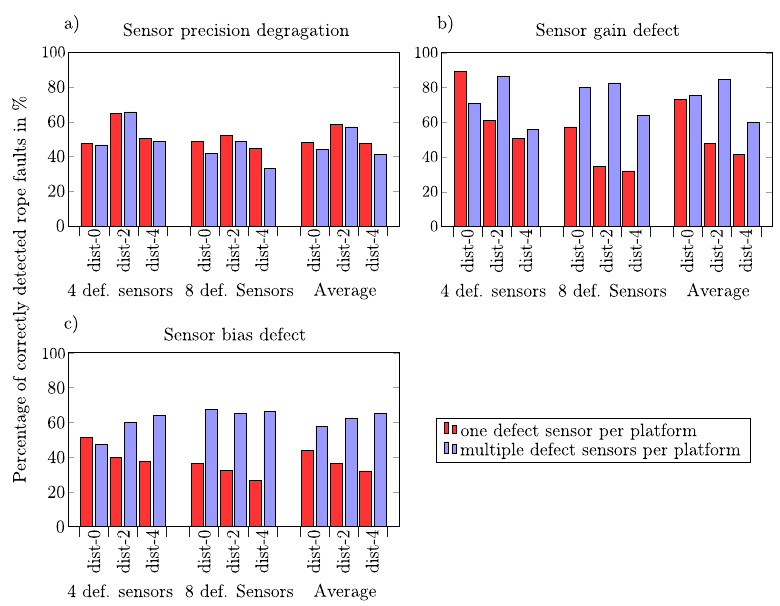
Figure 17. Comparison of single and multiple sensor defects per platform on the reliability of rope fault detection for a rope fault in rope number 1 with 3 z acceleration sensors per platform. Results for three different distances between defect sensors and the rope fault are shown: ( a ) For sensor precision degradation, ( b ) for sensor gain defects and ( c ) for sensor bias defects.